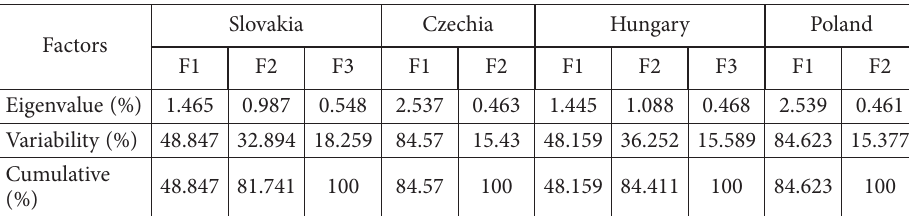
Table 1. Number of computed factors (source: authors)